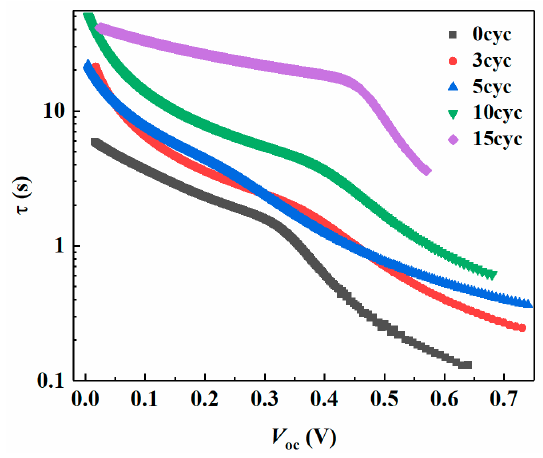
Figure 7. Effective electron lifetime curves of the IO-TiO 2 /CdSe QDSSCs, of which the IO-TiO 2 electrodes were passivated with (from 1 cycle to 15 cycles) and without ZnS.